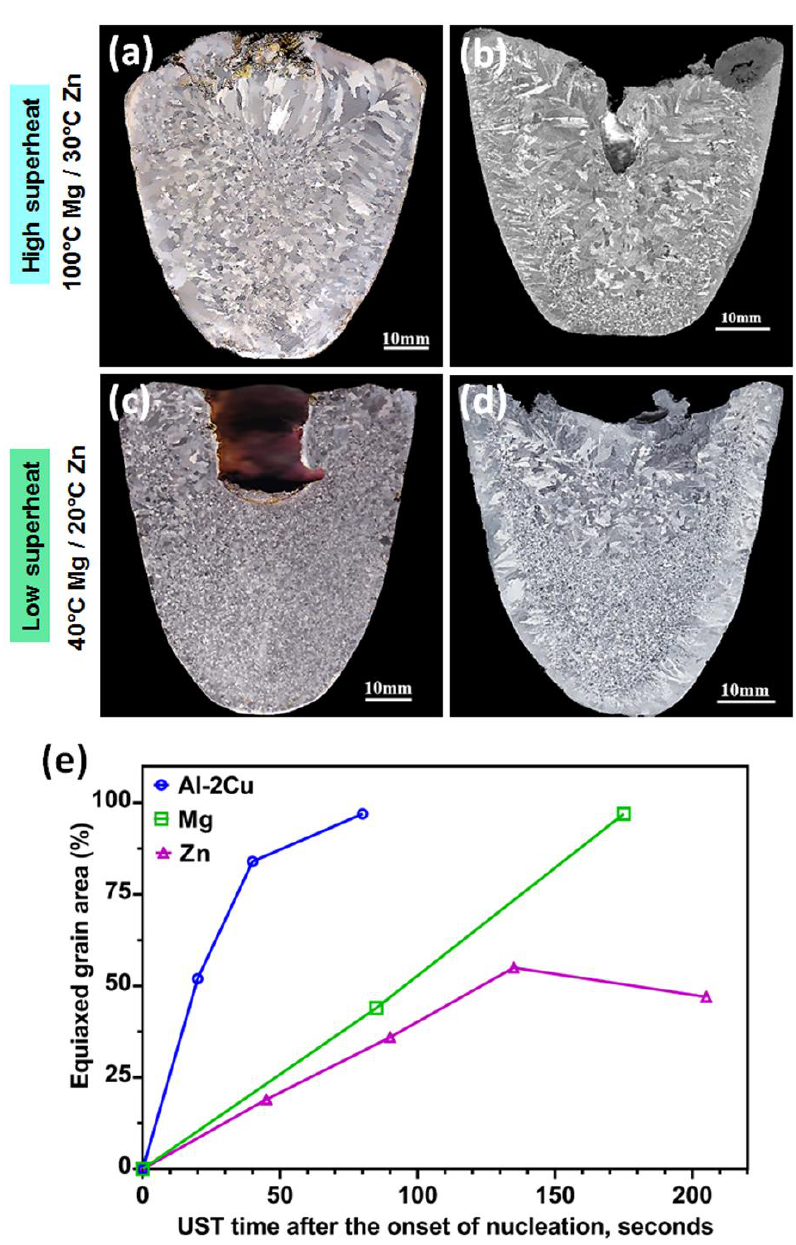
Figure 9. Macrostructures after UST was applied during solidification at ( a , b ) high and ( c , d ) low superheat (temperature at which UST is turned on above the melting temperature) in ( a , c ) pure Mg and ( b , d ) pure Zn [43,44]. ( e ) Equiaxed grain area measured from the cross section of the casting with respect to UST time after the onset of solidification [43,44,76].